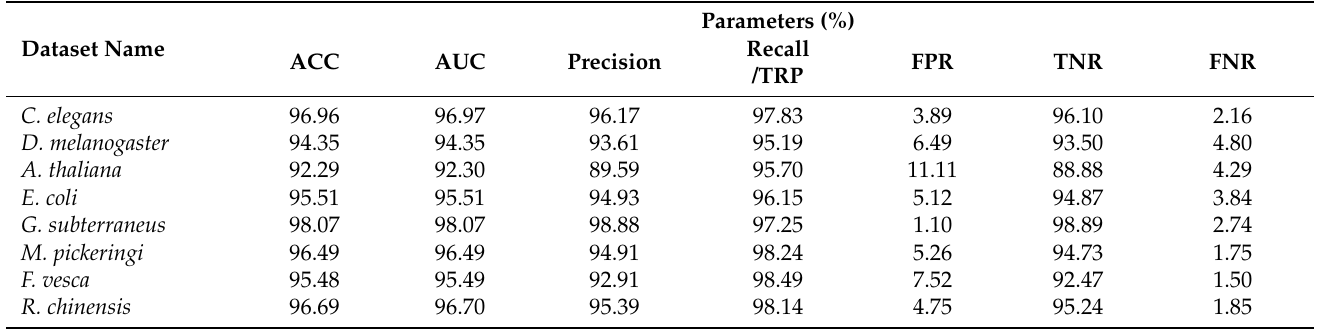
Table 6. Performance evaluation metrics result from the proposed approach (GS-MLDS) based on a different